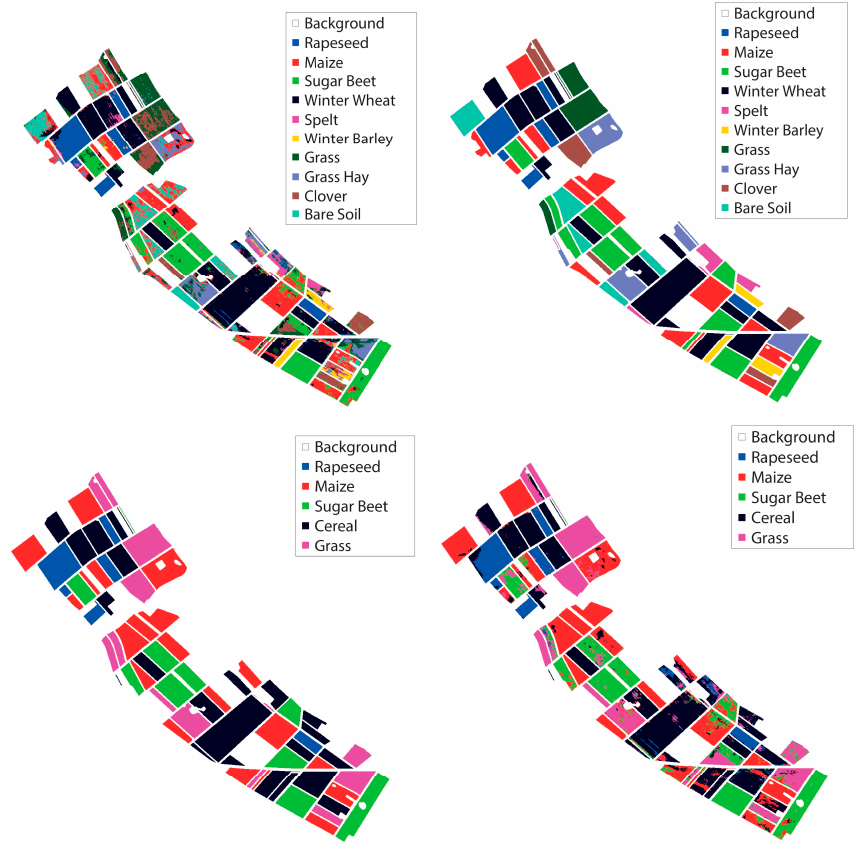
Figure 5. Land cover maps for the 5SE-RGB setting at 0.5 m spatial resolution. Full set of crop classes ( top ), merged set of crop classes ( bottom ), pixel-based classification ( left ), and parcel-based classification ( right